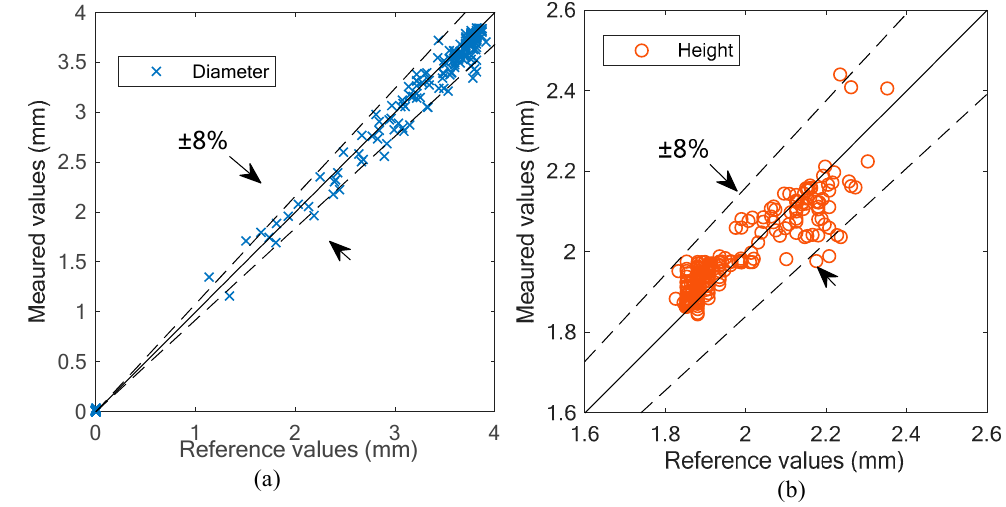
Figure 11. Experimental results: ( a ) cross-sectional diameter; ( b ) cross-sectional height.